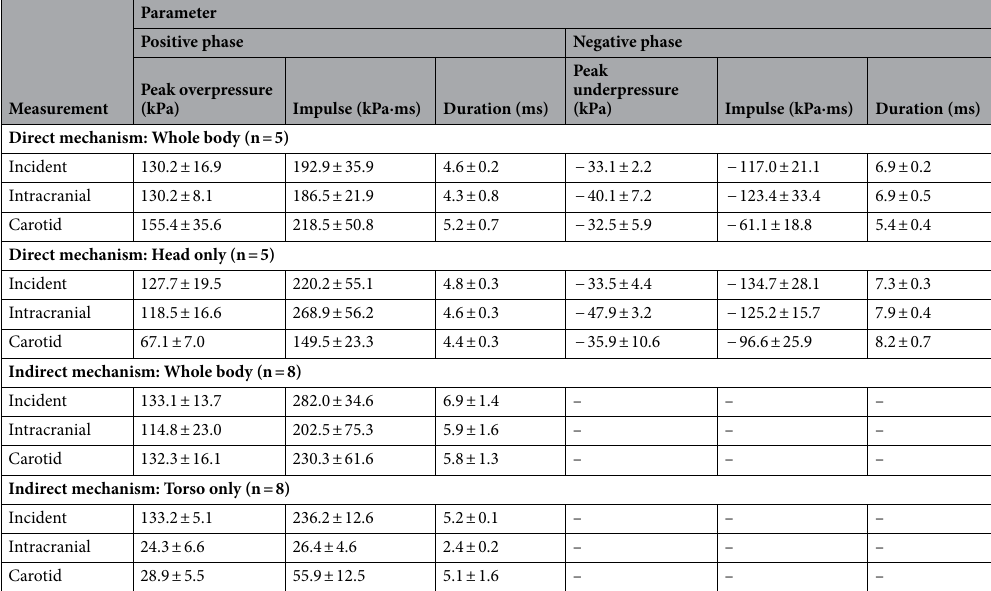
Table 1. Summary of relevant blast-wave parameters (mean ± one standard deviation) measured in the shock- tube experiments.